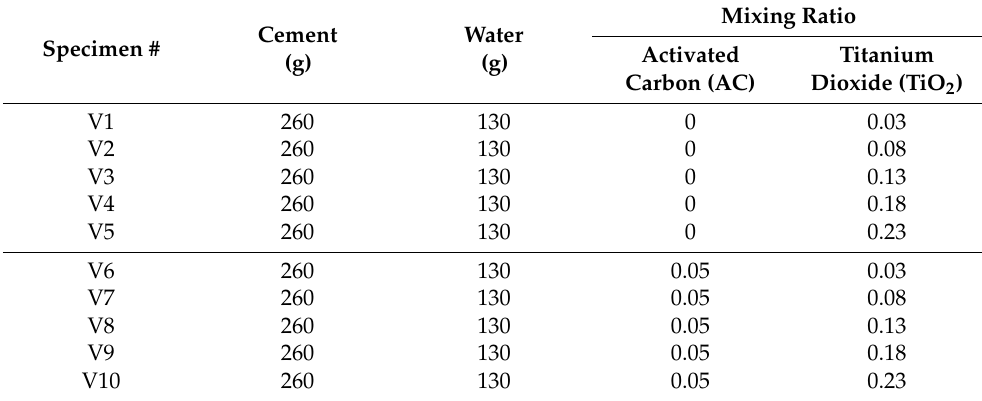
Table 2. Test cases for algorithm verification.